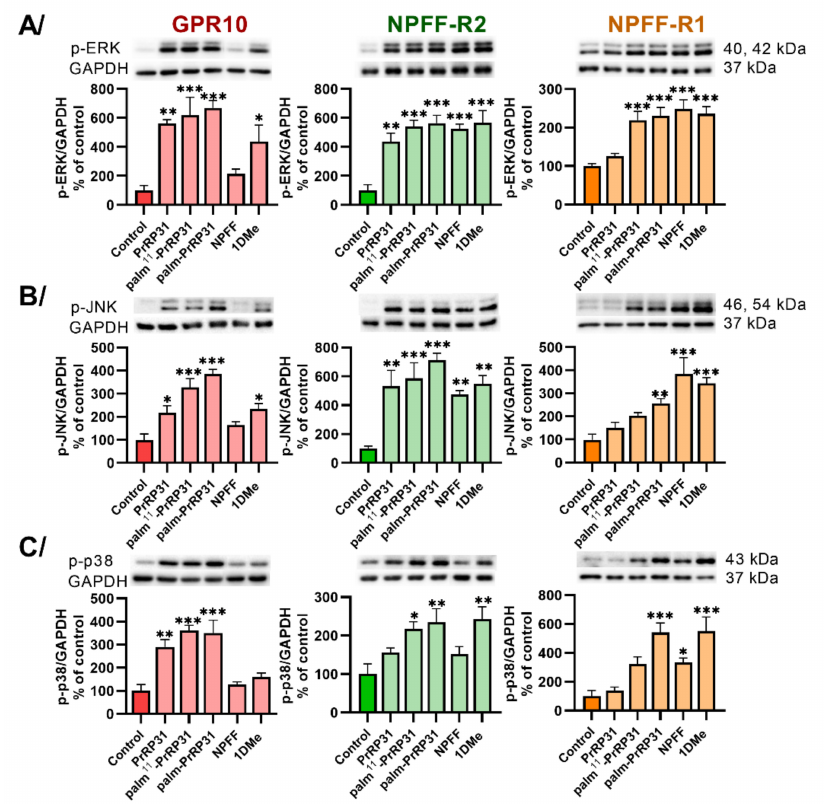
Figure 3. Induction of MAPK pathways: phosphorylation of ( A ) ERK and ( B ) JNK after 5 min and ( C ) p38 after 60 min of incubation at 37 ◦ C with peptides at final concentrations of 10 − 6 M in CHO-K1 cells expressing receptors GPR10, NPFF-R2 and NPFF-R1. Densitometric quantification was normalized to GAPDH, and the phosphorylation level in the untreated control was standardized as 100%. Data are presented as the mean ± SEM and analyzed by two-way ANOVA followed by Dunnett’s post hoc test. Experiments were performed independently at least three times. Statistically significant differences from the control are indicated (* p < 0.05, ** p < 0.01, *** p < 0.001).